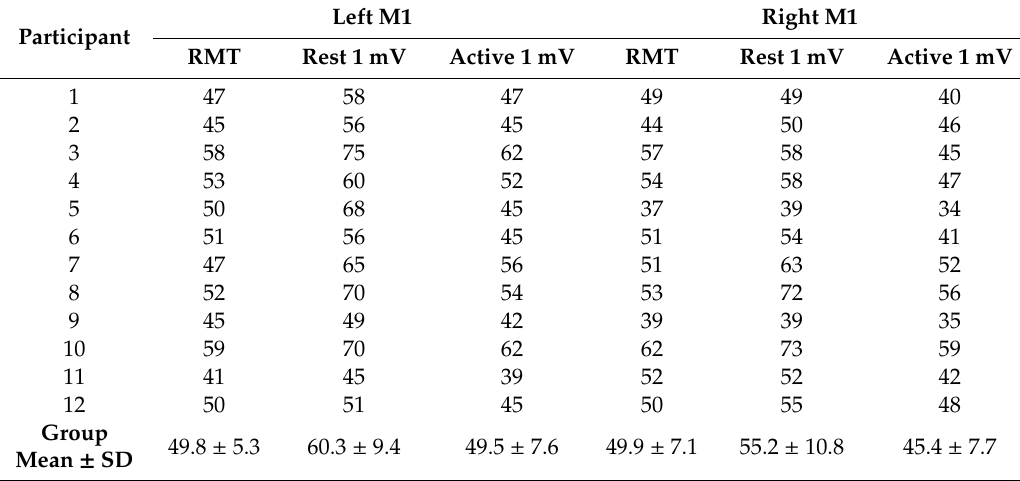
shown for both the left and right primary motor cortex (M1) for each participant and group mean and standard